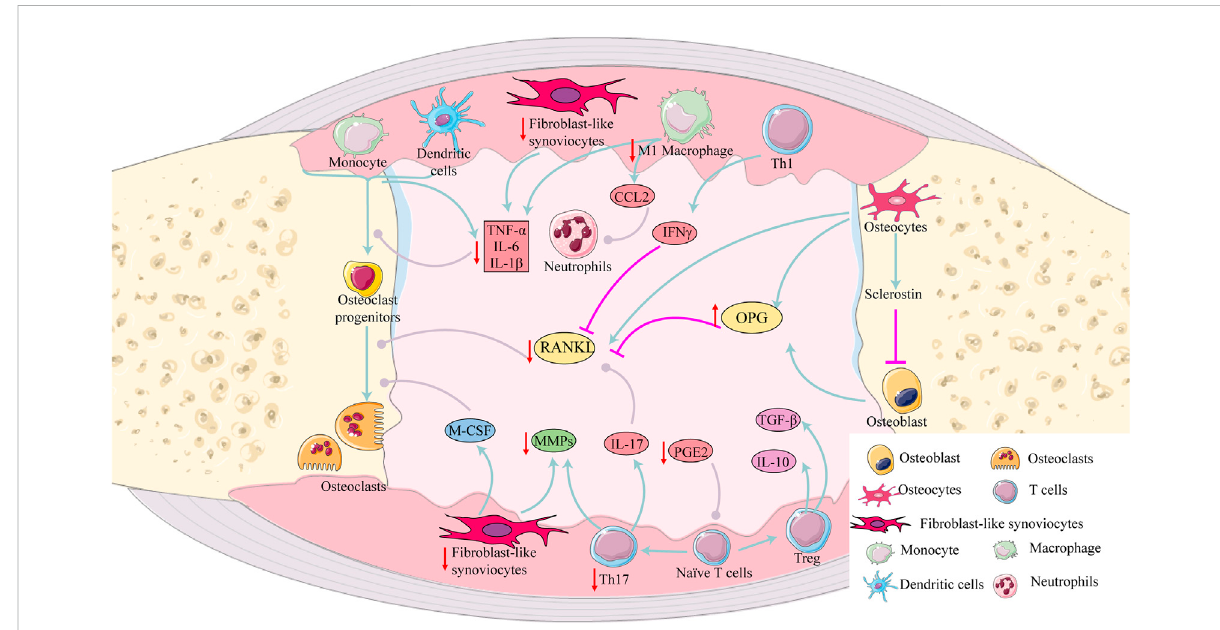
FIGURE 5 Aschematicviewofanti-RAeffectsoficariin( ↑ =up-regulation; ↓ =down-regulation;redarrow=icariin)(imagescitedfromServierMedicalArt images at